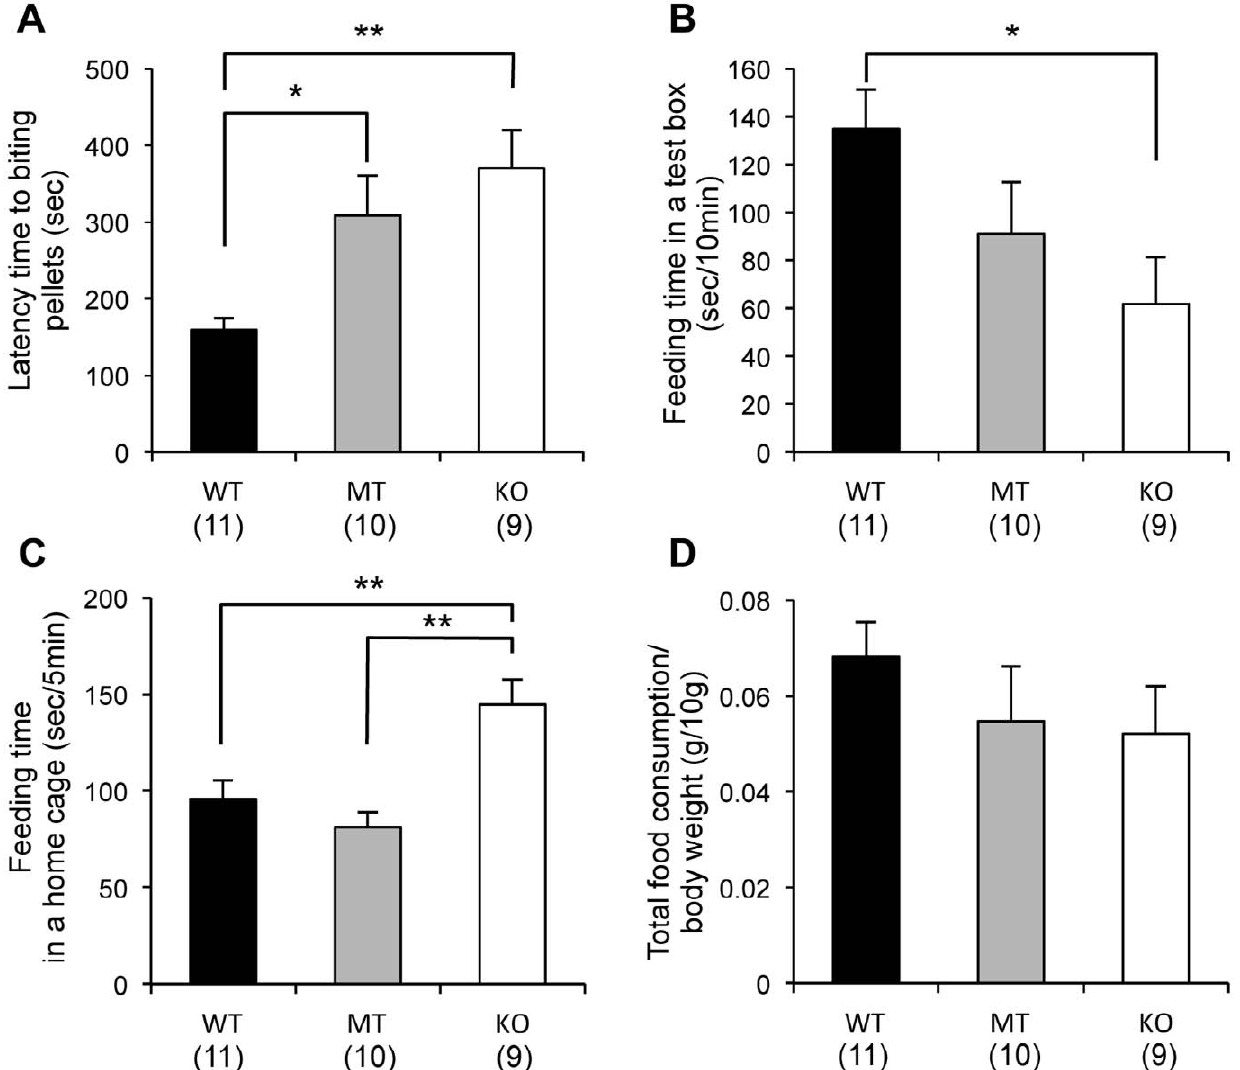
Figure 4. Novelty-suppressed feeding test. (A) Usp46 MT and KO mice showed an increased latency time to bite pellets in a test box. (B) Feeding time in the test box for 10 min. KO mice exhibited significantly lower feeding times. (C) Feeding time in the home cage for 5 min. The KO